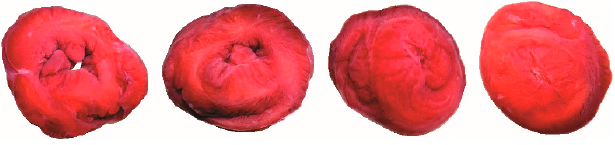
Figure 2. Negative control of staining heart slices after freezing.